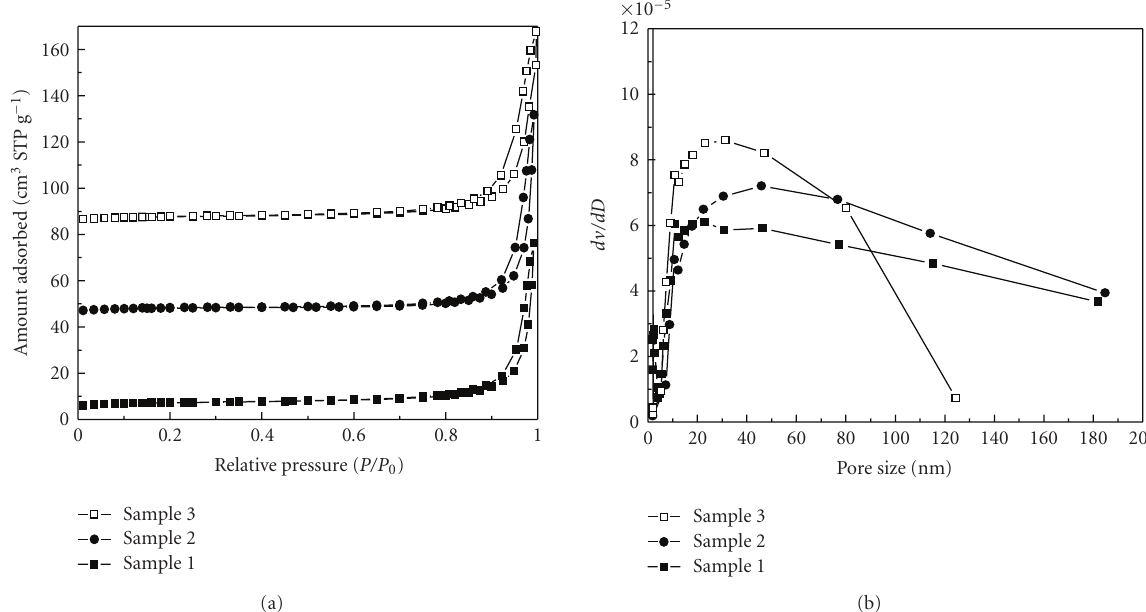
Figure 4: N 2 adsorption-desorption isotherms (a) and BJH pore-size distributions from adsorption branches (b) for the samples. The isotherms for sample 2 and sample 3 are o ff set vertically by 40 and 80 cm 3